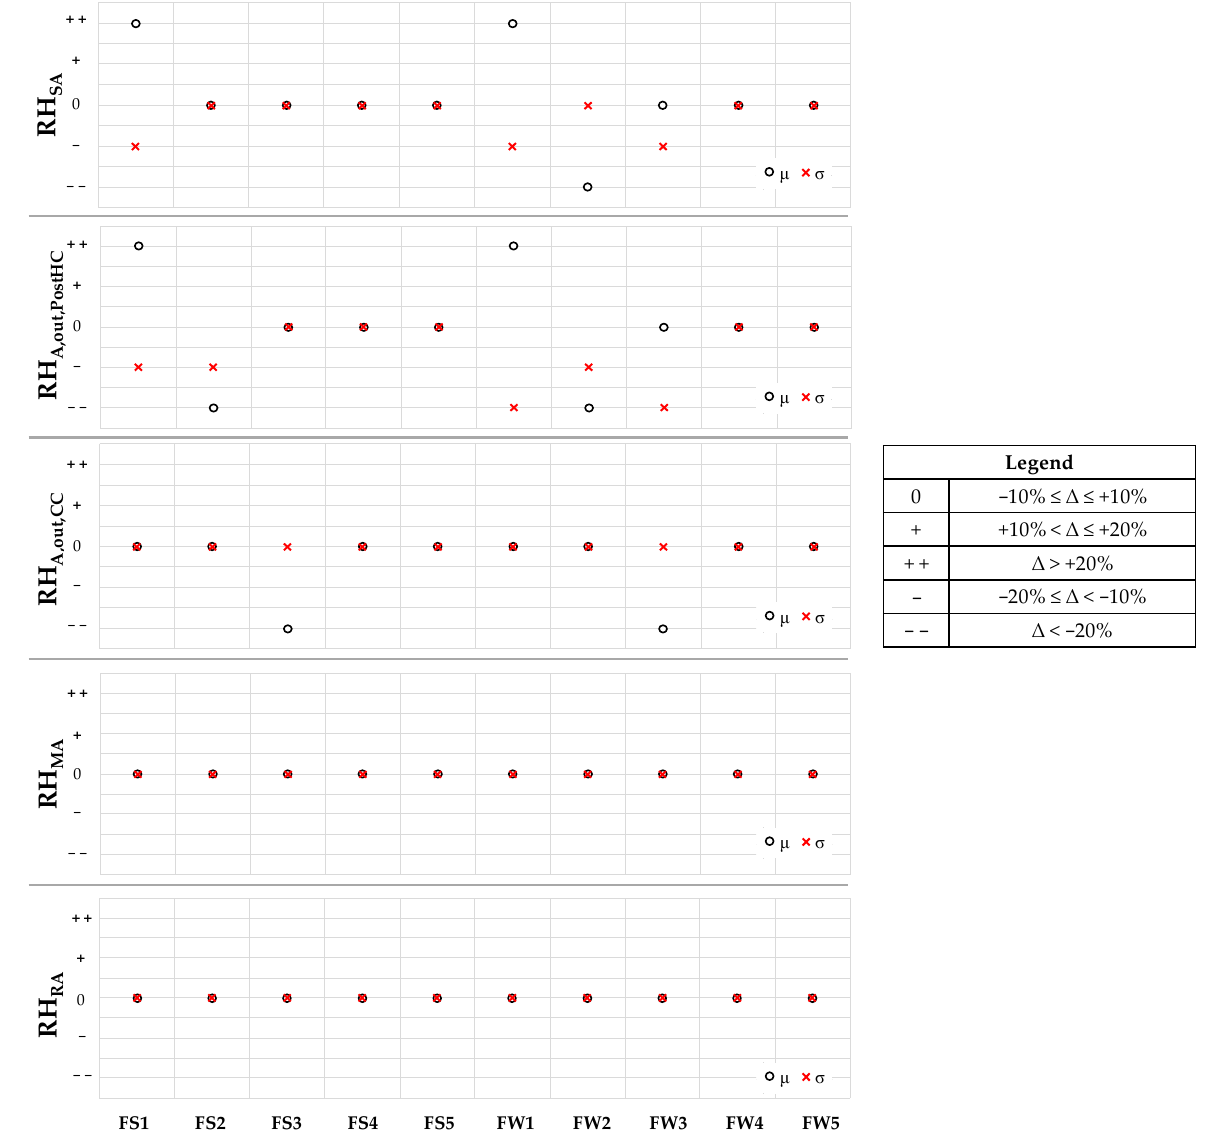
Figure 10. Symptoms’ relevance to the selected faults in terms of air relative humidity.